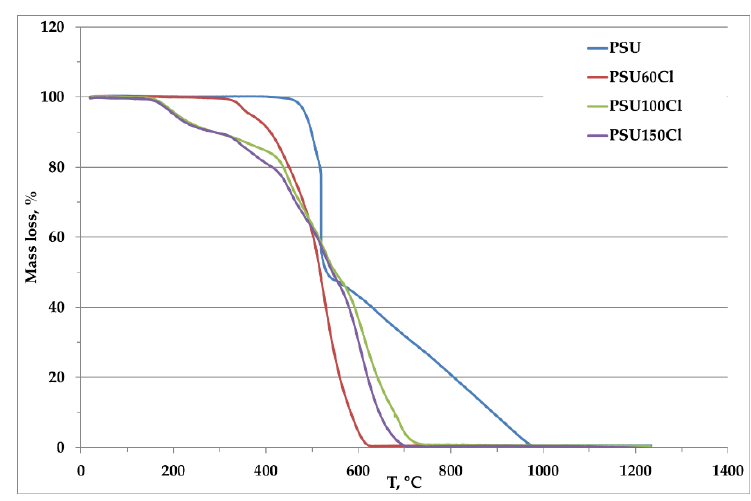
Figure 4. Comparison of thermograms of chloromethylated samples and pristine PSU.